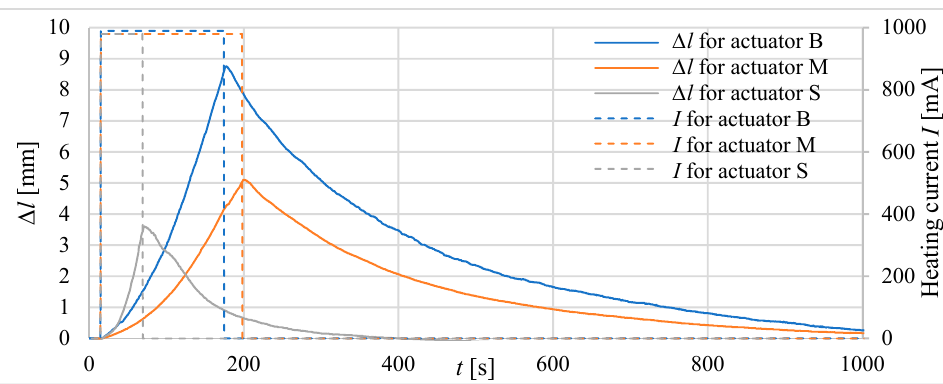
Figure 18. Relative elongation for bellow actuators. For the bellow actuators investigated, the relative elongation at a temperature of 75 °C ranged between 15% and 20%. This is less than for tube actuators, which can elongate to 36%. This is the consequence of the influence of the spring forces of the bellows. The bellow actuators are also slower than the tube actuators when they are heated under sim- ilar conditions (compare curves in Figures 11 and 18). The heating times are presented for comparison in Table 4, where it is visible that the bellow actuator with a similar volume to the tube actuator needed more time during heating to reach 75 °C. The bellow actuators act slower, not only because of the influence of the spring force of the metal bellow but also because their shapes are bigger, which resulted in greater dissipation of heat to the atmosphere during heating. Table 4. Comparison of selected actuators. All actuators were heated with a current of approxi- mately 1 A with heaters with this same resistance. Actuator